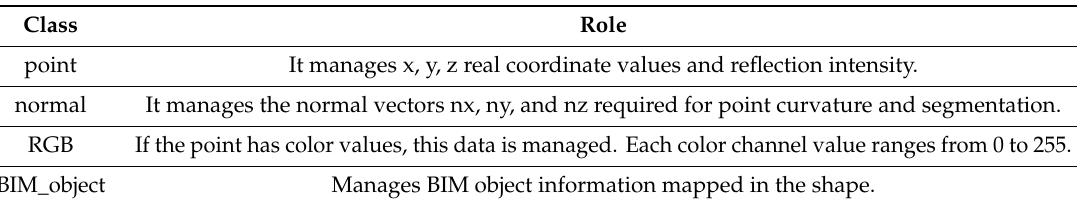
Table 4. Scan-to-BIM data structure class definition.